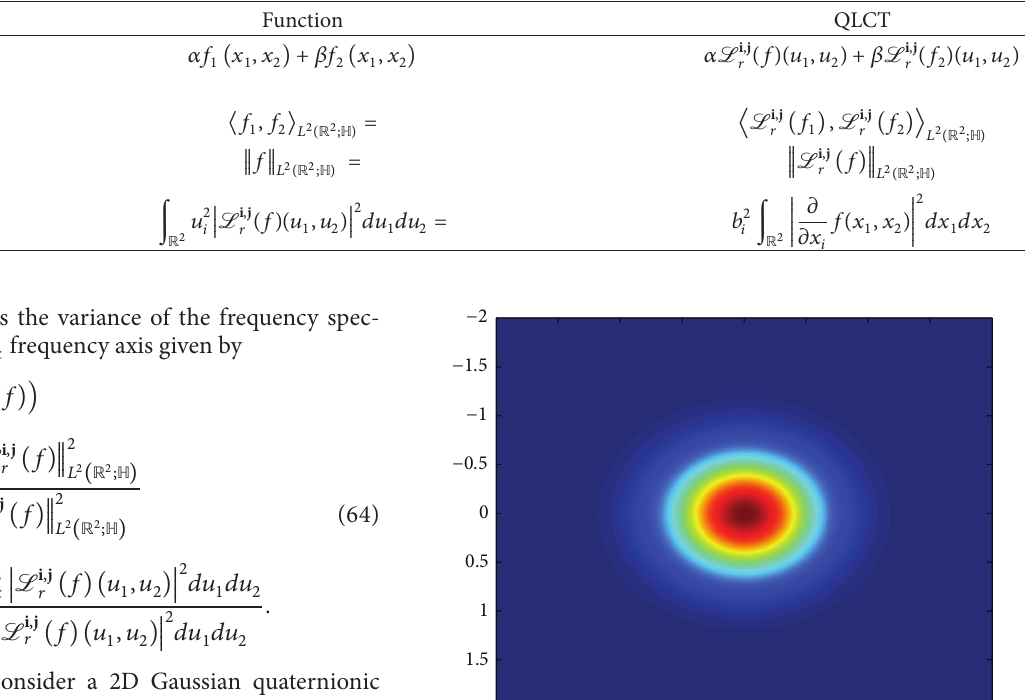
Table 1: Properties of the